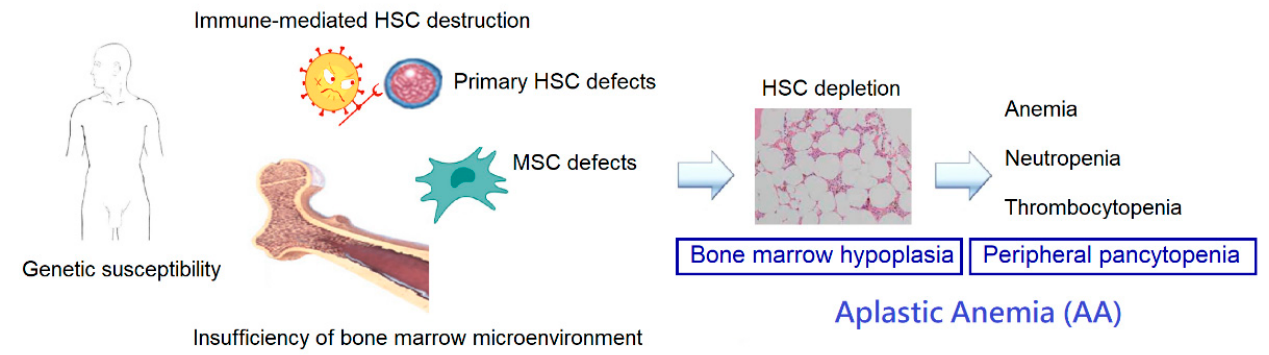
Figure 1. Pathophysiology of acquired idiopathic aplastic anemia.